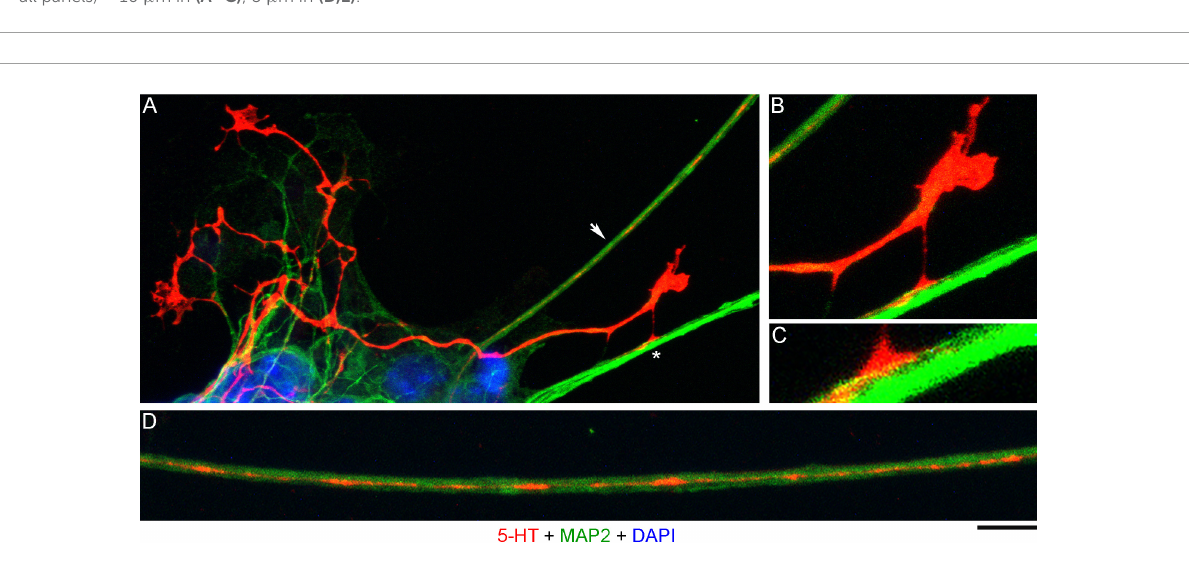
FIGURE3 A primary midbrain culture (neuron-glia co-culture at DIV 3), visualized with immunocytochemistry for 5-HT (red) and MAP2 (green) and imaged with high-resolution confocal microscopy. Cell nuclei are stained blue (DAPI). (A) A serotonergic axon (5-HT + /MAP2-) that advances along a 5-HT–/MAP2 + neurite and reveals its adhesion sites (one site is marked with an asterisk). (B) An enlarged view of the growth cone region in (A) . (C) A further enlarged view of the adhesion site marked with an asterisk in (A) . (D) Relatively regularly spaced putative adhesion sites (5-HT + /MAP2-) on a 5-HT-/MAP2 + neurite (an enlarged part of (A) , arrow). Scale bar (shared by all panels) = 10 µ m in (A) ; 5 µ m in (B,D) ; 2 µ m in (C)